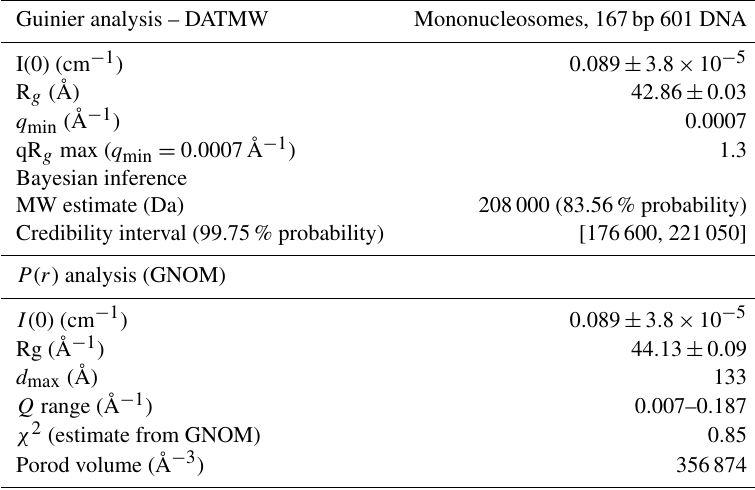
Table 2. Analysis of SAXS data of soluble